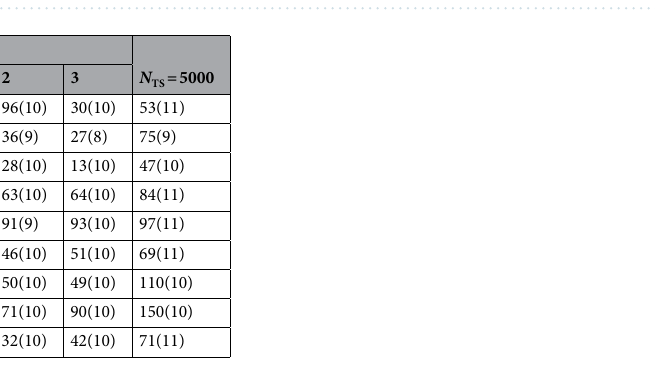
Figure 3. Two cases of gerrymandering with rook constraint. In each case, the top panel shows the distribution of the dominant cells where 1(0) means a cell that Party A(B) has an advantage over B(A). Middle panels show the calculated correspondence between the cells and the 14 districts indexed from 0 to 13. The bottom panels show the assignment of seats based on the calculated districting.